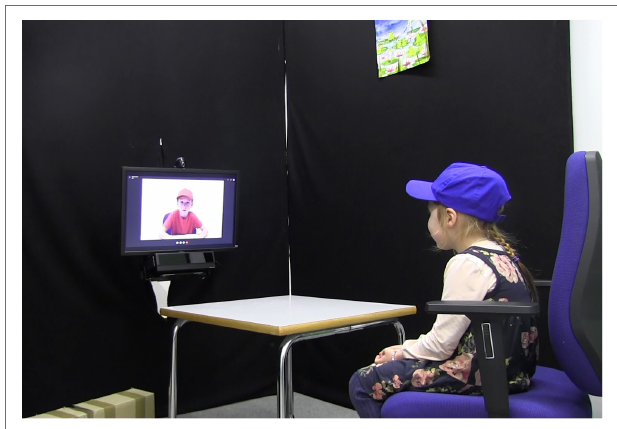
FIGURE 1 | Setup during the individual skype calls (test